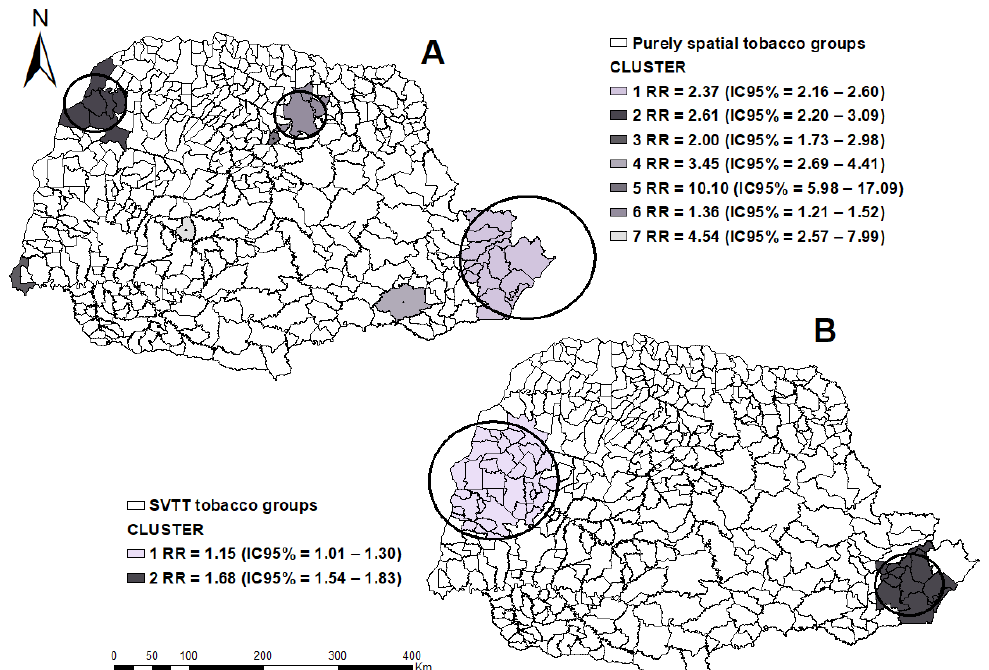
Figure 3. Areas at spatial risk for tuberculosis in tobacco users, by municipalities, state of Paraná (2008–2018). ( A ) applied the purely spatial technique; ( B ) applied the purely Spatial Variation in Temporal Trends. Legend: ArcGIS [GIS software]. Version 10.0. Redlands, Califórnia, EUA: Environmental Systems Research Institute, Inc., 2010. The SVTT for this condition pointed to two risk Hotspots, with Cluster 1 extending from the West to the Northwest mesoregion, with ITT = 70.8 annual growth and ETT = 35.7% growth per year, and Cluster 2 in the Metropolitan region of Curitiba with LLR= 21.6 ITT = 52.7% and ETT = 34.8% annual growth (Figure 3B). Regarding TB cases and the use of other drugs, we observed 2.903 cases, and the incidence rate was 2.6 cases/100,000 inhabitants, with a 19.41% annual growth in the state (Figure 4). Figure 4A represents the EVPP, which identified five clusters of spatial risk in the West, North Central, and Metropolitan regions of Curitiba.